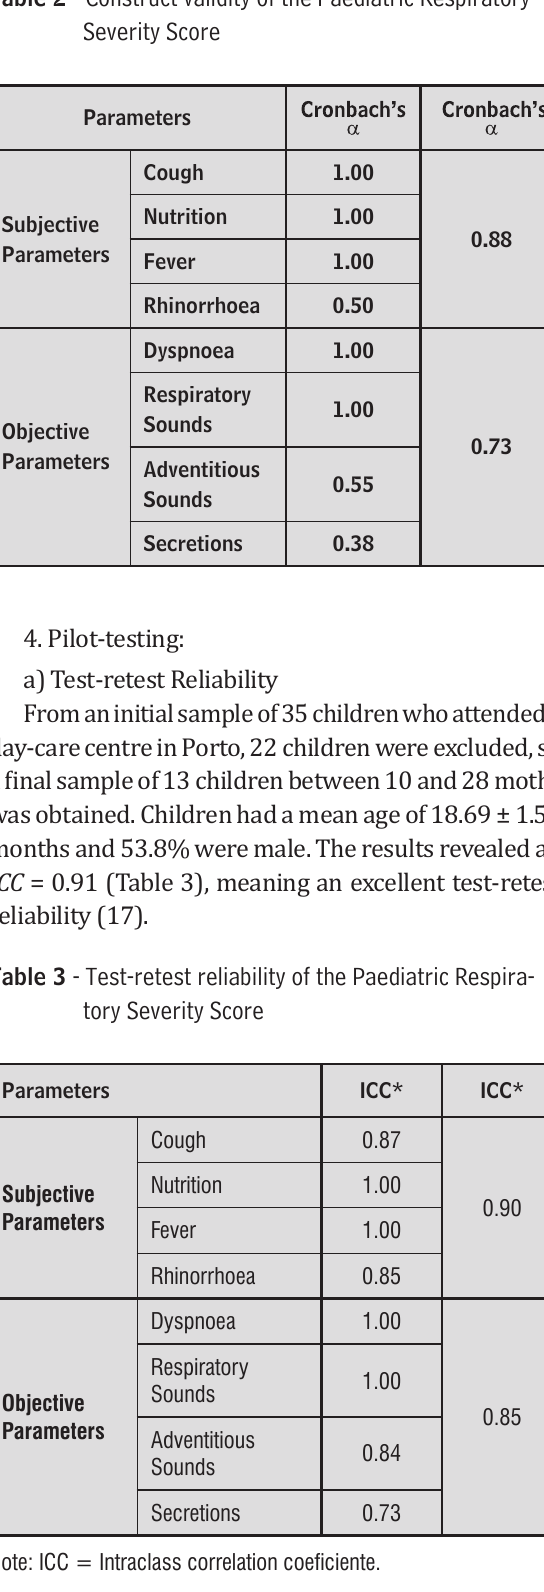
Table 2 - Construct validity of the Paediatric Respiratory